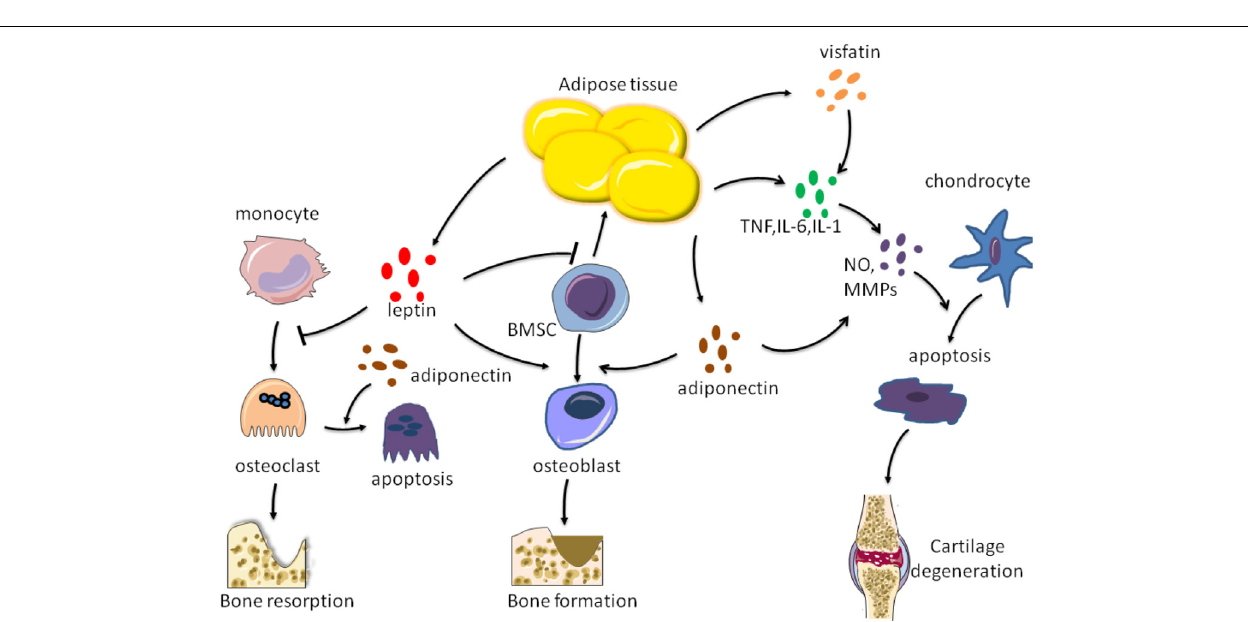
FIGURE 2 | Effects of factors secreted by adipose tissue on bone metabolism. Adipose tissue can secrete leptin, adiponectin, visfatin, TNF- a, IL-6, and IL-1 These factors act on chondrocytes, osteoblasts, osteoclasts, respectively, to regulate bone formation and resorption, as well as cartilage